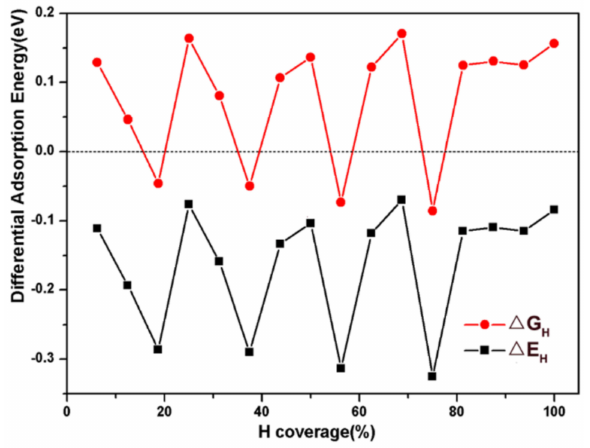
Figure 4. Adsorption energy ( ∆ E H ) and adsorption free energy ( ∆ G H ) as functions of hydrogen coverage on MoP 2